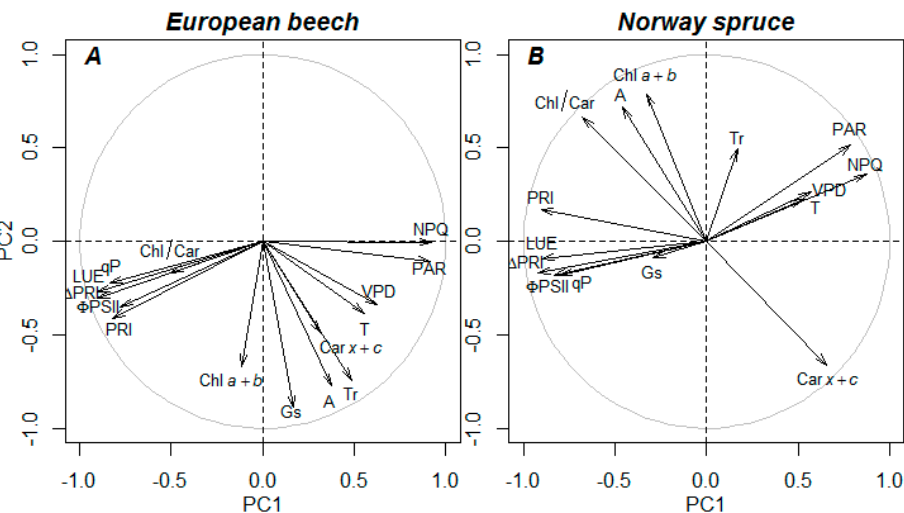
Figure 8. Two-dimensional canonical graph of the variable factorial map (correlation circle of the principal component analysis) showing interactions between spectral information (PRI, photochemical reflectance index; ∆ PRI, differential PRI), environmental conditions inside growth chambers (PAR, photosynthetically active radiation; T, temperature; VPD, vapor-pressure deficit), data measured with the use of active fluorimeter ( Φ PSII , quantum yield of photosystem II photochemistry; qP, photochemical fluorescence quenching; NPQ, non-photochemical quenching), gas-exchange system ( A , CO 2 assimilation; LUE, light use efficiency; G s, stomatal conductance; Tr , transpiration) and foliar pigment (chlorophyll and carotenoids) contents (Chl a+b , Car x+c , Chl a+b /Car x+c ). Direction indicate responsibility for PC1 (horizontal) or for PC2 (vertical), length reflect the correlations between active variables and principal components. Angle between variable shifts indicates correlation between variables vectors, and values are listed in Supplementary Figures S2 and S3.